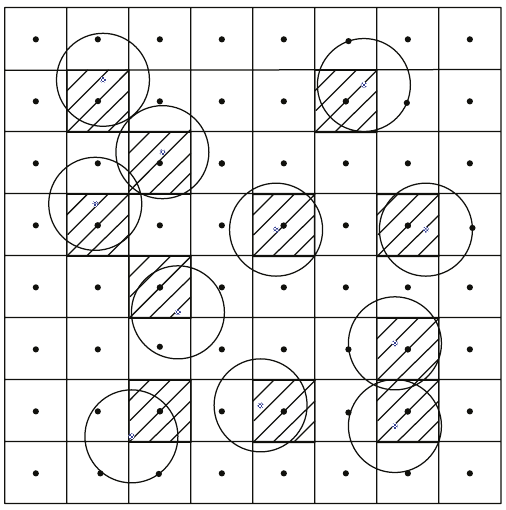
Figure 2: Sensor network with only static nodes.